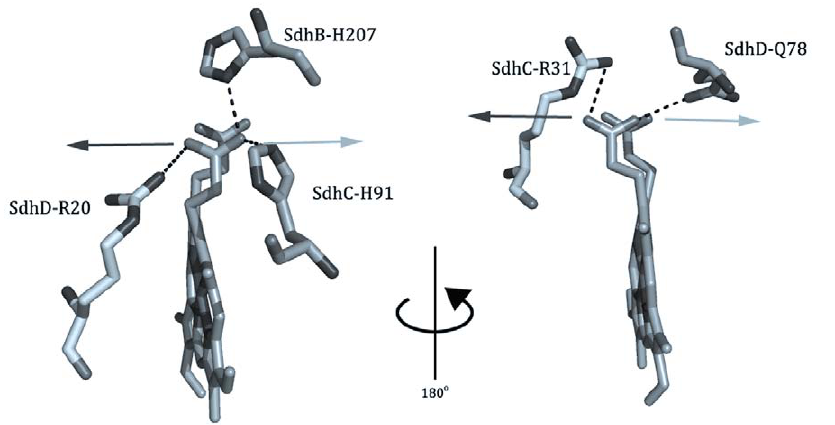
Figure 4. The hydrogen-bonding network around the heme propionates. The distal propionate is highlighted on the left while the proximal propionate is shown on the right. Each propionate is held in position by residues on either side. Mutation of SdhD R20 and SdhC R31 to a Leu results in the propionate shifting towards the other ‘‘girder’’ (light arrows). Mutation of SdhC H91 and SdhD Q78 to a Leu causes a shift of the propionate in the other direction (dark arrows). Note the twisting of the porphyrin ring into a saddled conformation in this structure. (pdb: 2WDV [31]).